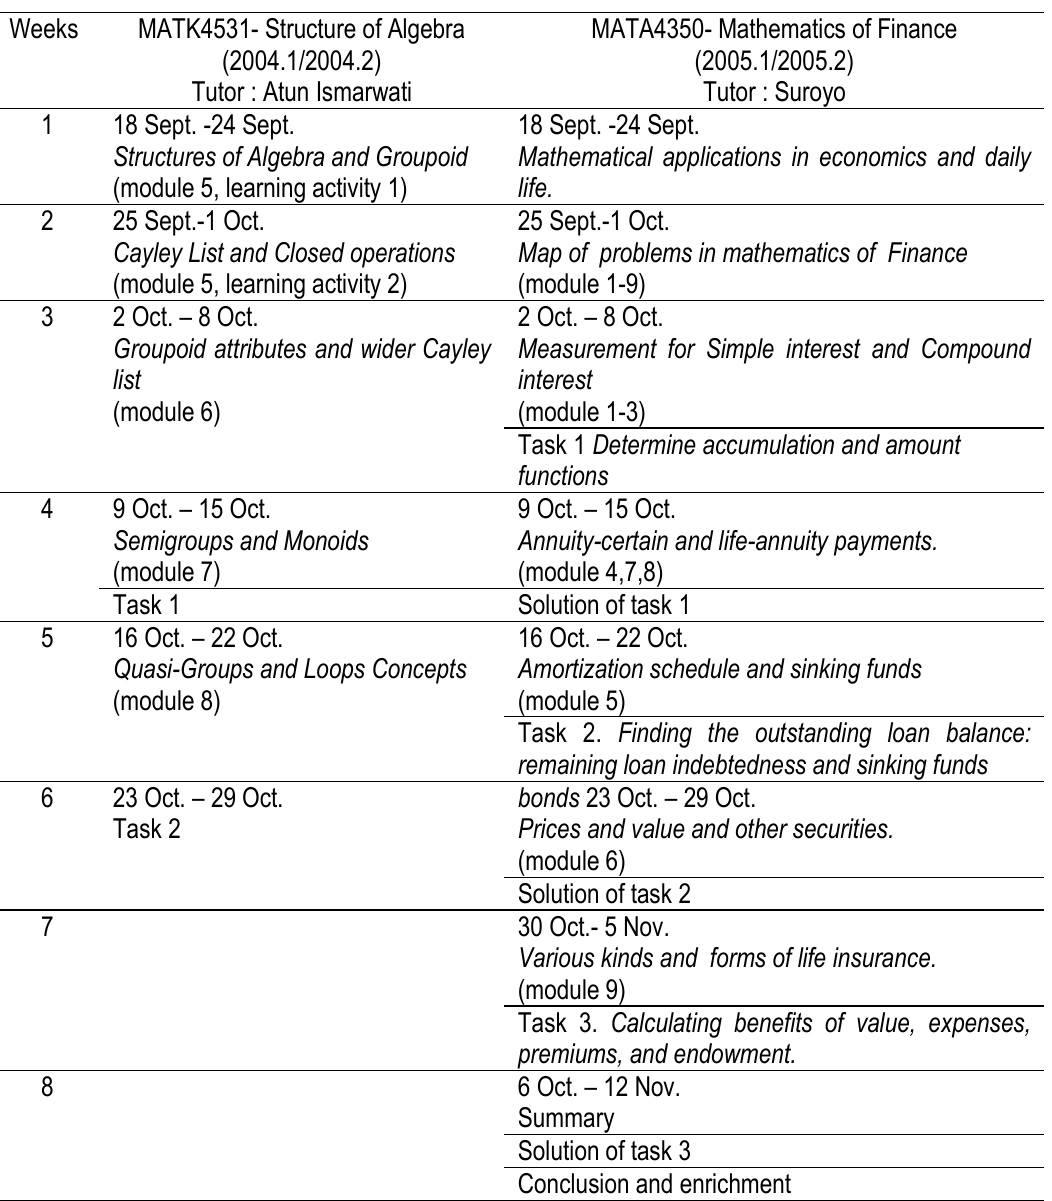
Table 2. Comparison of Tutorial Online for MATA4321-Structure of Algebra (2004.1/2004.2) and MATA4350- Mathematics of Finance (2005.1/2005.2) in